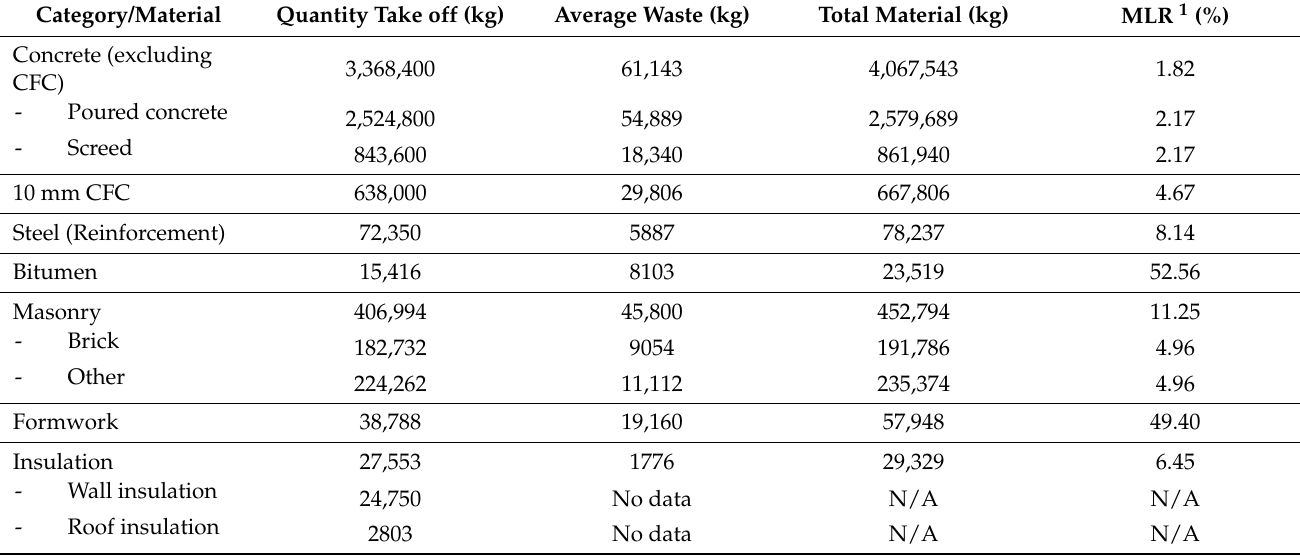
Table 6. Average waste generation for Case B conventional